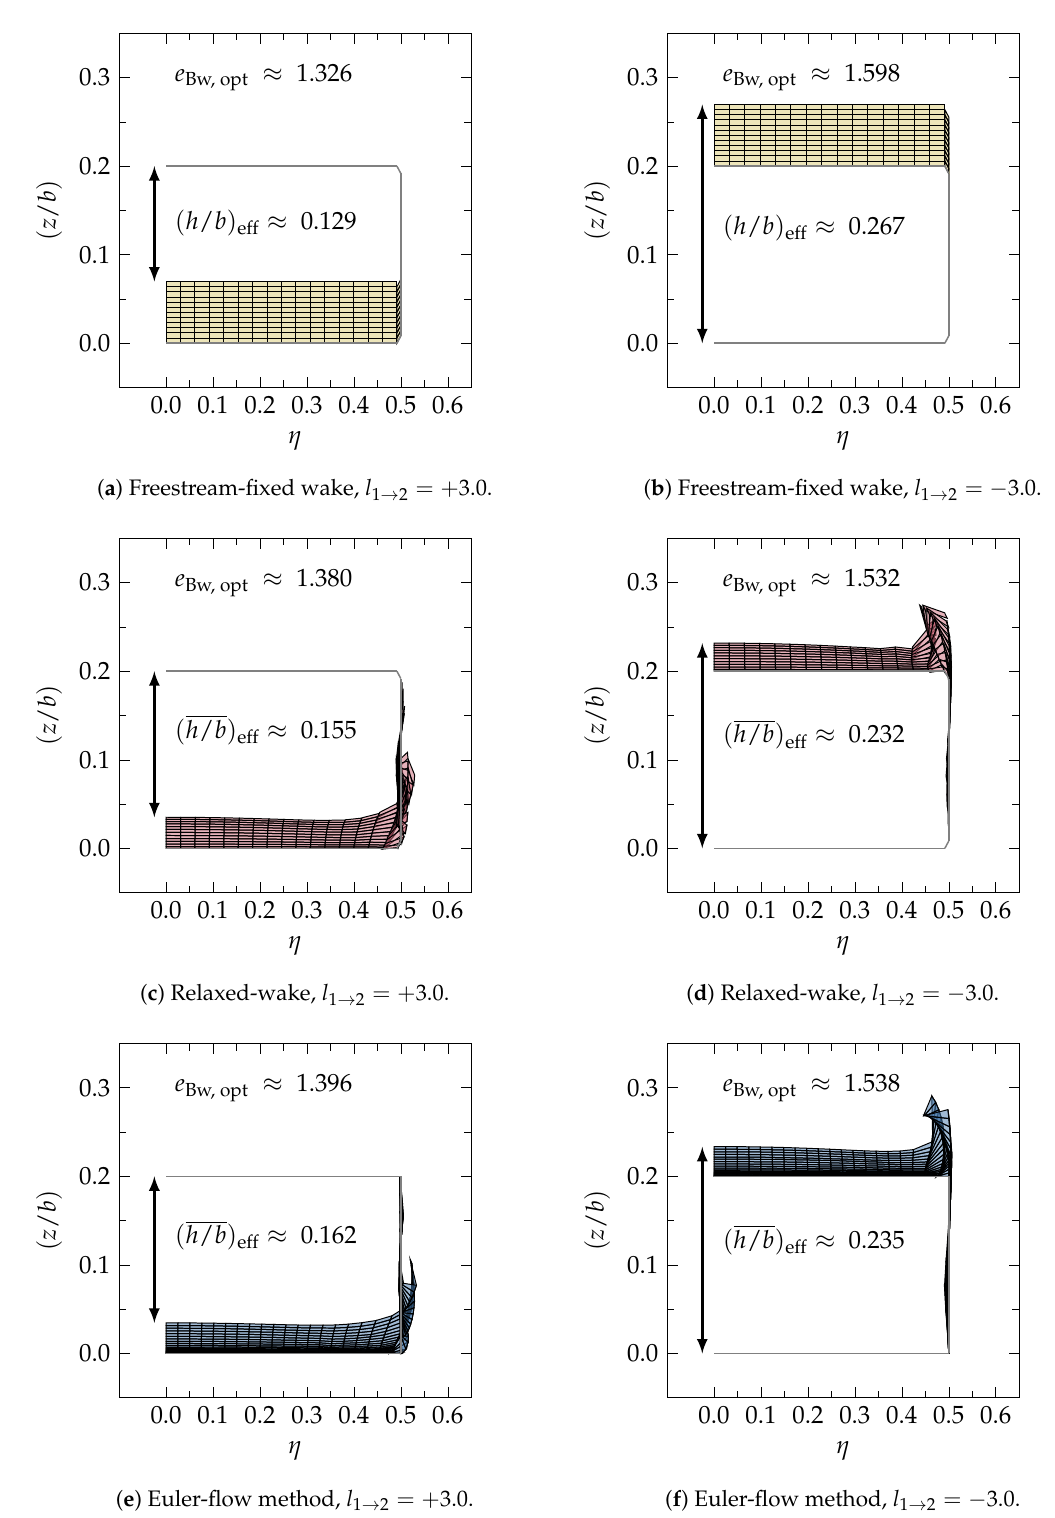
Figure 6. Wake trace comparison for a freestream angle of attack of α = 8.0 ◦